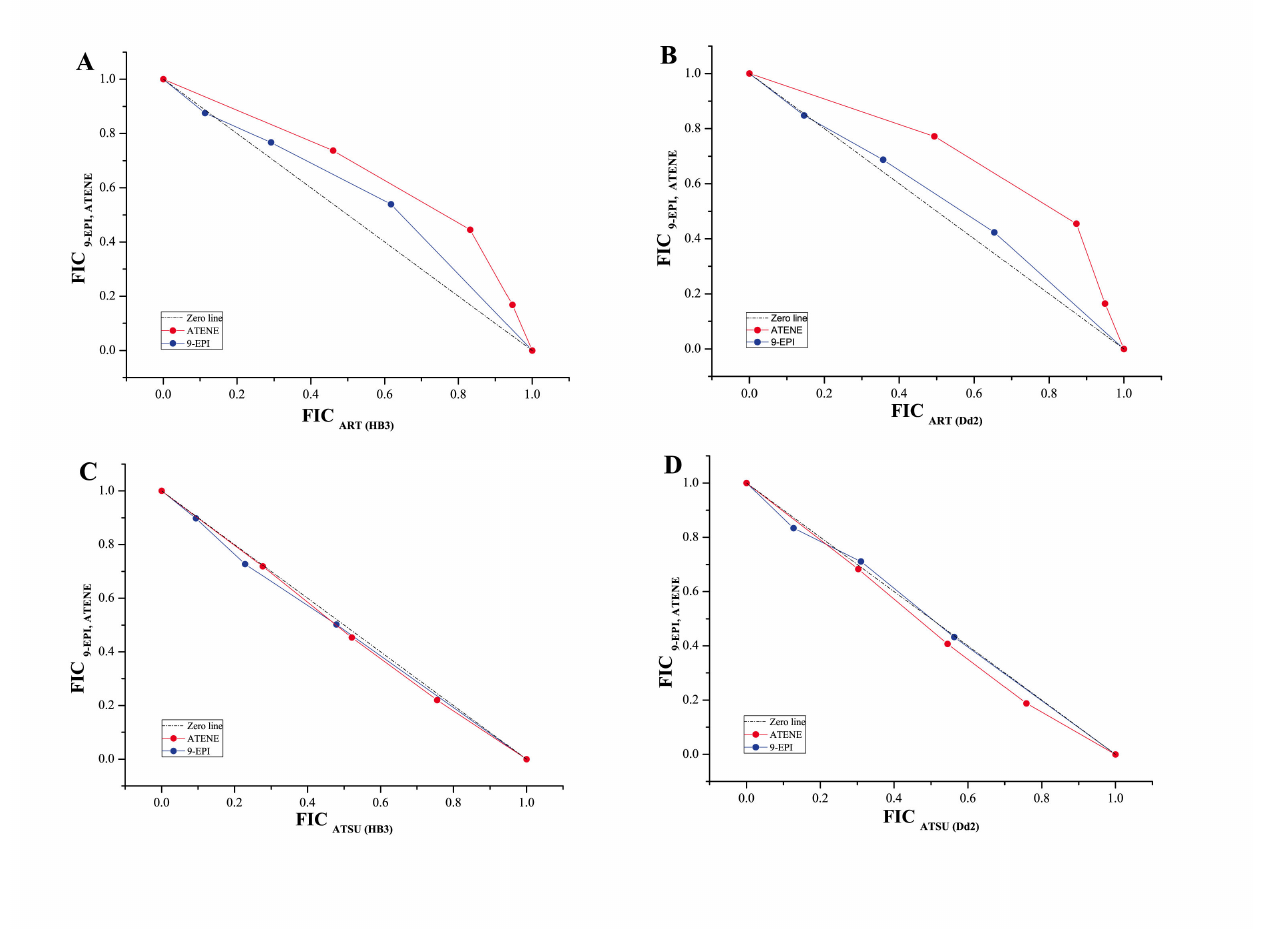
Figure 2. Isobologram showing the plot of fractional inhibitory concentration (FIC) of 9-epi-artemisinin (EPI) and artemisitene (ATENE) against FIC of artemisinin (ART) and artesunate (ATSU). Panel A - interaction of EPI and ATENE with ART in chloroquine-sensitive (CQS) HB3 strain. Panel B – same as in A but in CQ-resistant (CQR) Dd2 strain. Panel C - interaction of EPI and ATENE with ATSU in HB3. Panel D – same as C but in Dd2 parasite. doi: